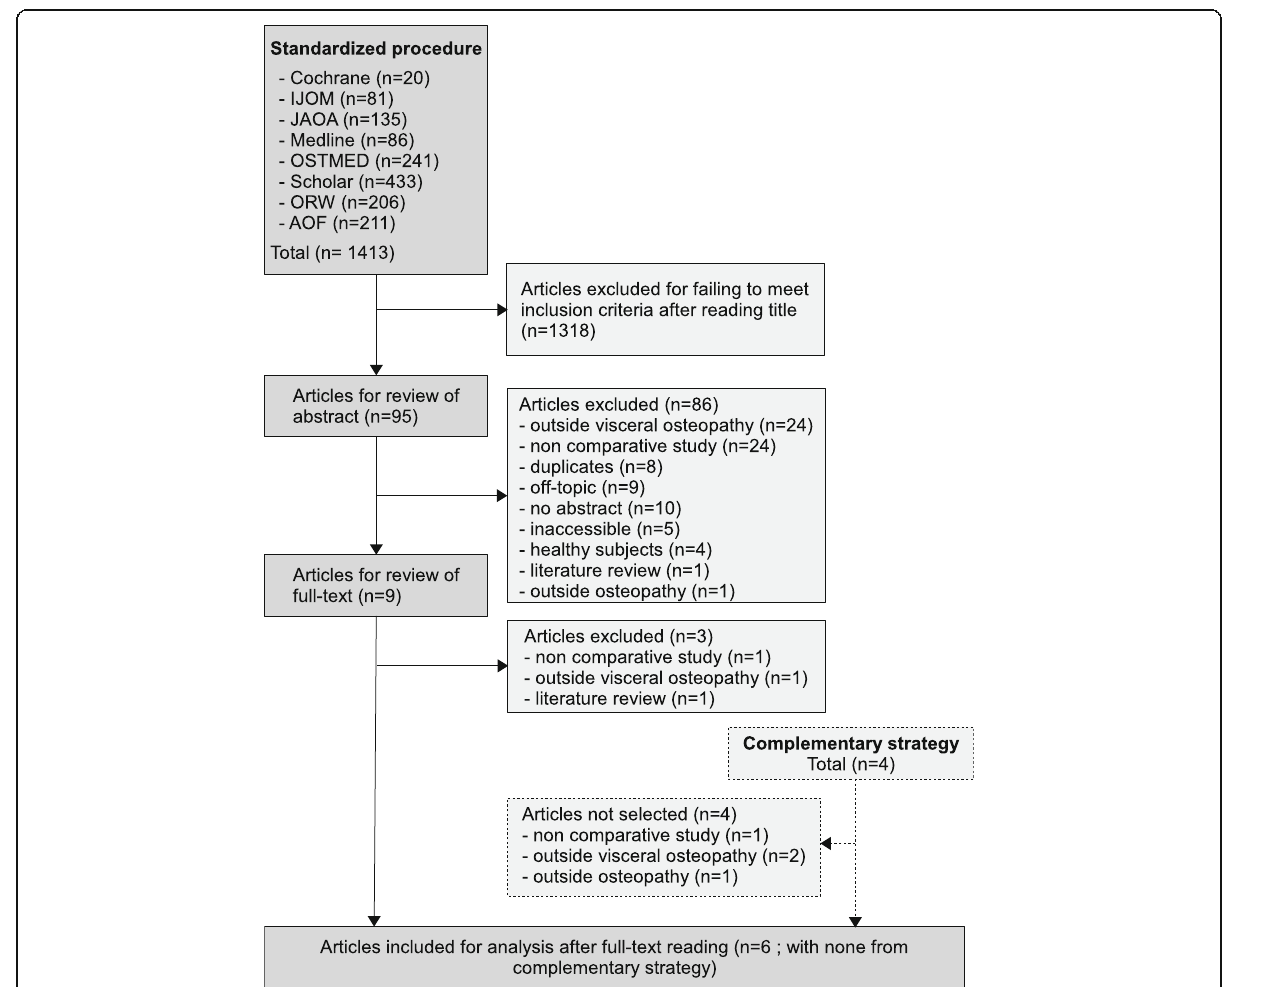
Fig. 4 Selection process for studies dealing with the clinical efficacy of techniques and therapeutic strategies used in visceral